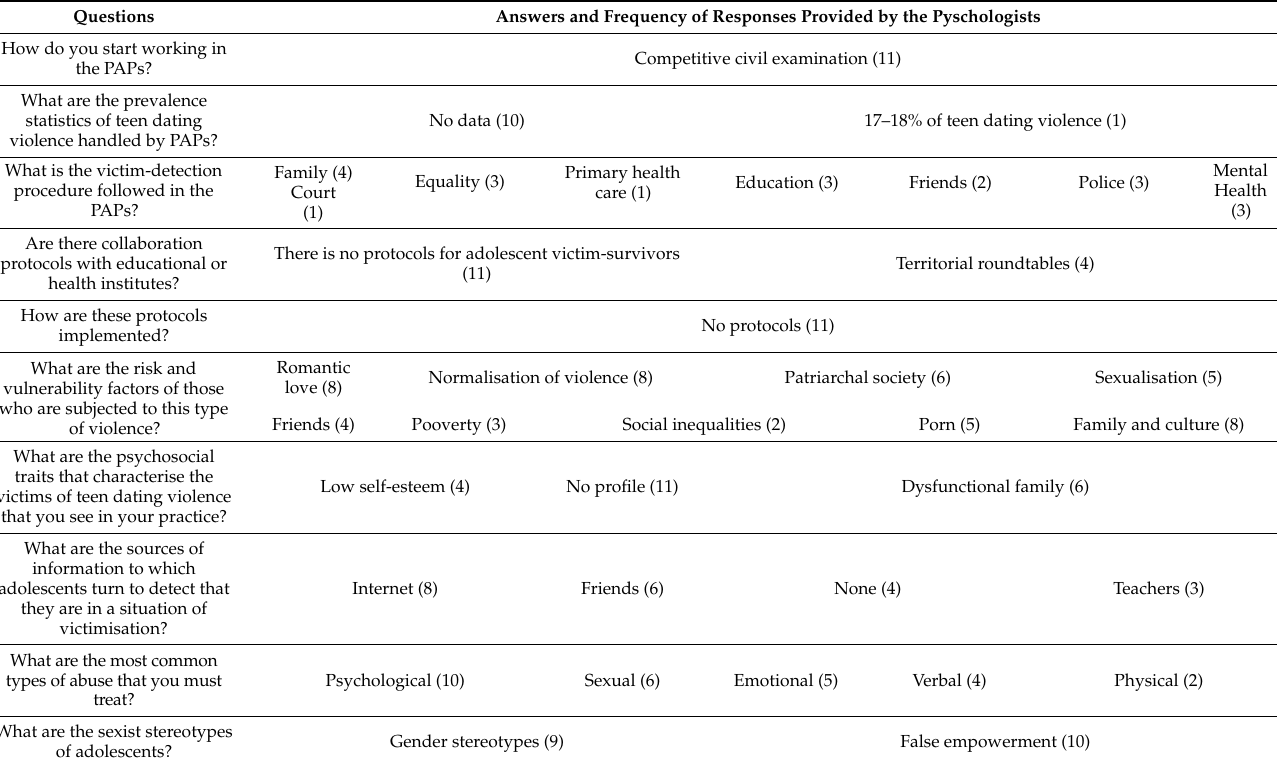
Figure 1. Research phases and categories. Table 4. Summary of answers and frequency of responses given by the